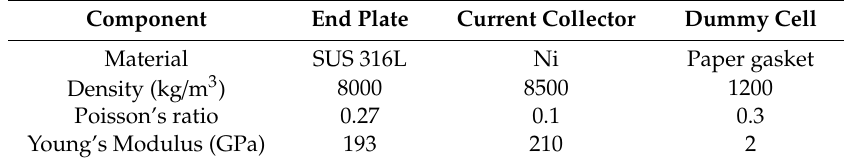
Table 1. Material properties of simplified proton exchange membrane water electrolysis (PEMWE) components.